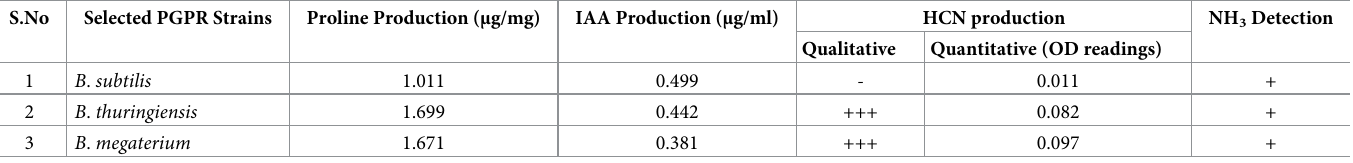
HCN production (based on intensity of color):—negative, +weak, ++ moderate, +++